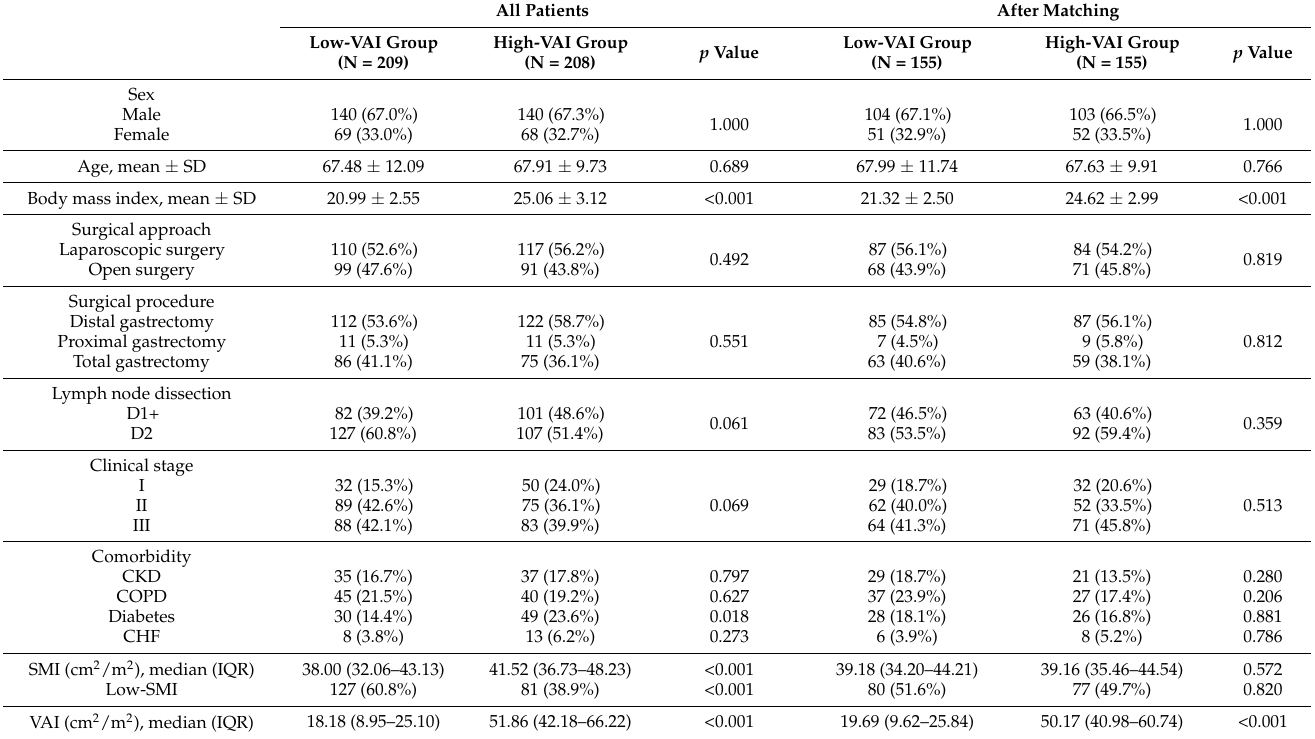
Figure 1. Study design. Table 1. Patient characteristics before and after propensity score matching.